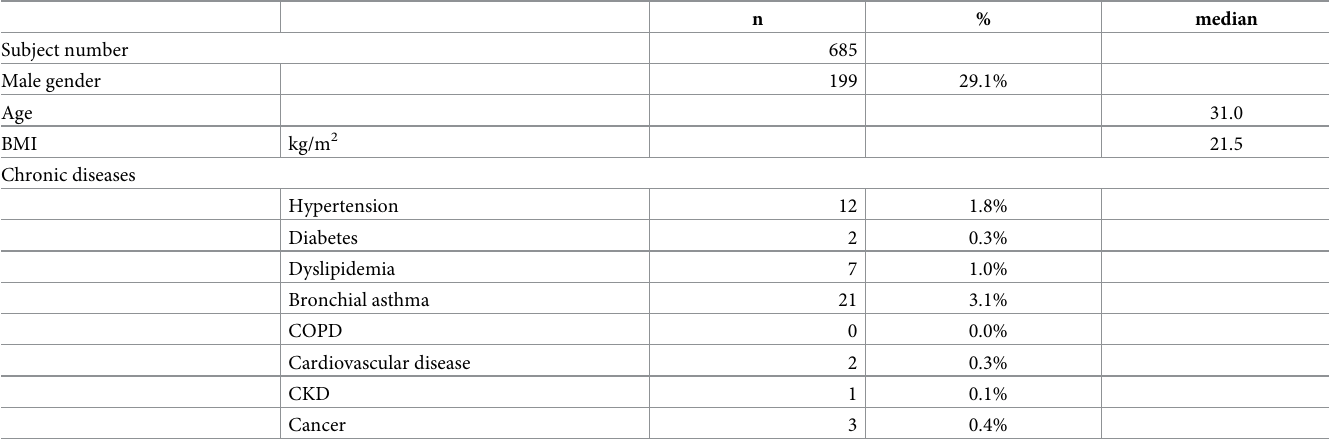
Table 1. Background characteristics of the study subjects.